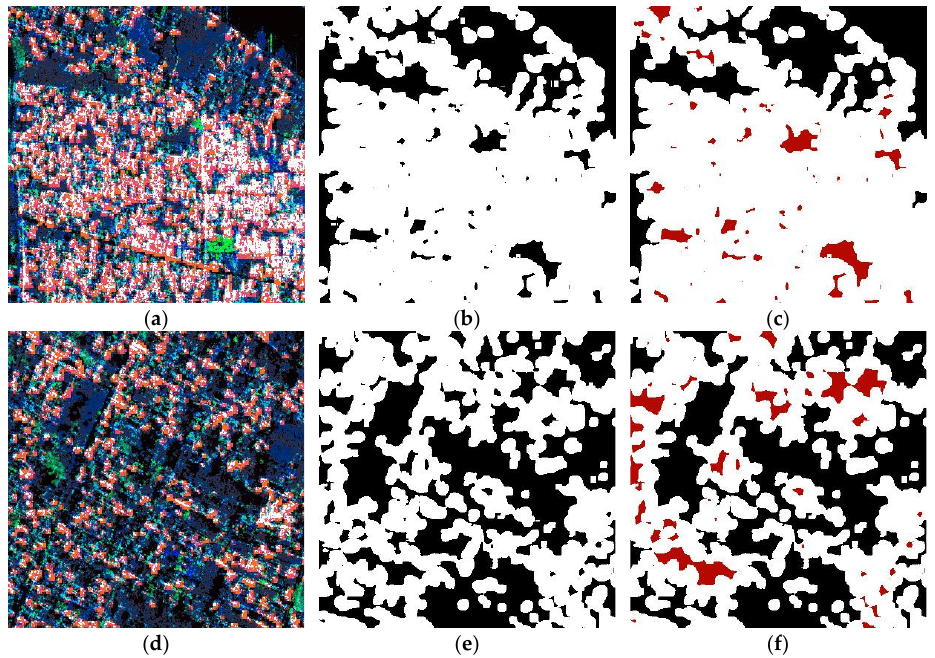
Figure 3. Object-based reasoning for filling the “holes” within the identified urban area. Dense urban area: ( a ) clustered Level-1α product, ( b ) coarse urban area map, and ( c ) holes (in red color) filled by analyzing the spatial relationship between neighboring objects. Sparse urban area: ( d ) clustered Level-1α product, ( e ) coarse urban area map, and ( f ) holes (in red color) filled by analyzing the spatial relationship between neighboring objects. Holes filled at this stage are marked with the numeric ID 1, indicating a “low density” urban area.